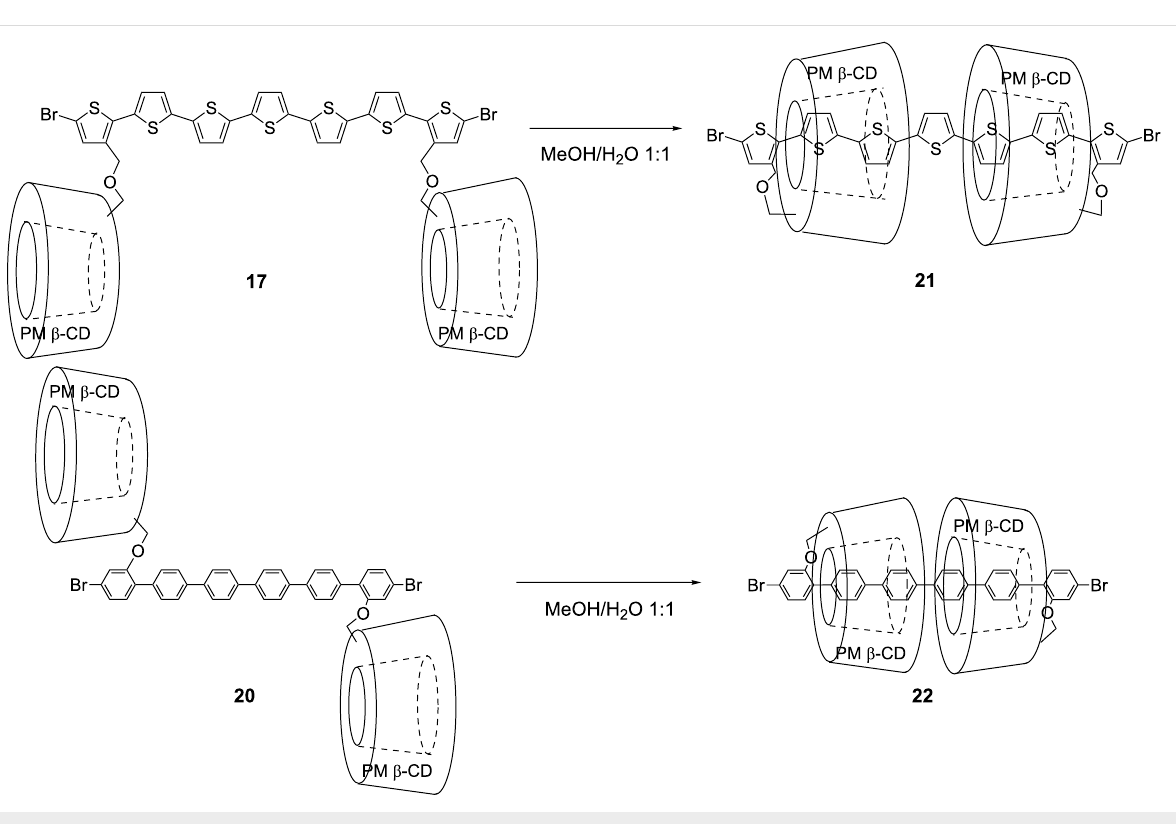
Scheme 5: Synthesis of pseudo-linked [3]rotaxanes via double self-inclusion through